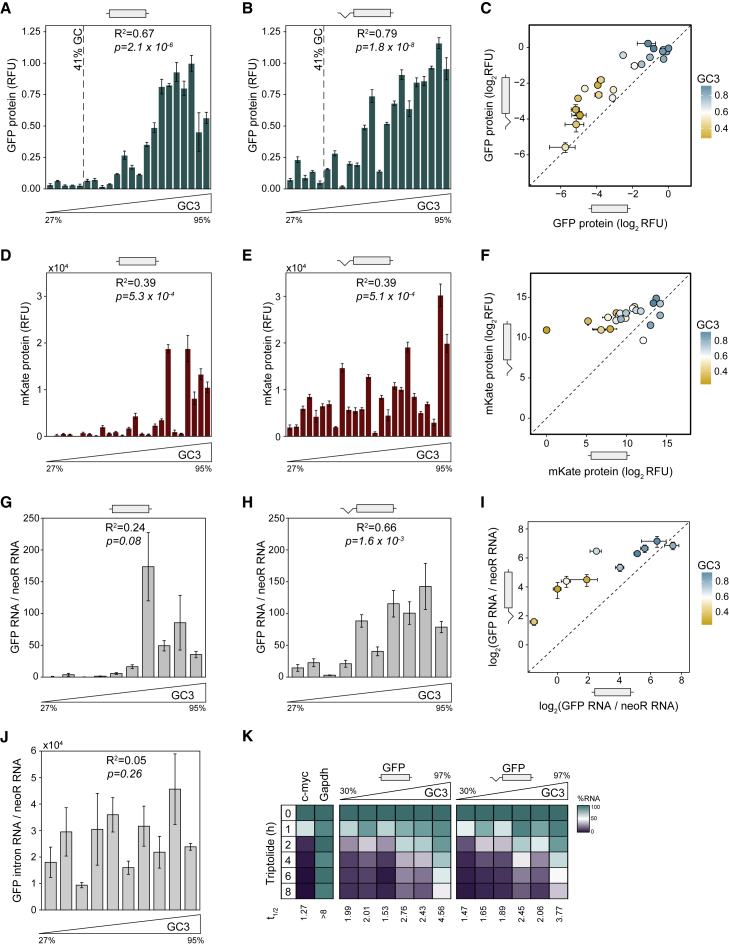
The Effect of GC Content on Gene Expression Depends on Splicing(A and B) Protein levels of 22 GFP variants when transiently expressed as unspliced (A) or spliced (B) constructs in HeLa cells and quantified by spectrofluorometry. Each data point represents the mean of 9 replicates ± SEM. GFP relative fluorescence units (RFU) are defined as (GFP fluorescence − background GFP fluorescence)/(mKate fluorescence – background mKate fluorescence), where background fluorescence was measured in mock-transfected cells.(C) Correlation of protein levels between unspliced and spliced variants of GFP (n = 22, R2 = 0.69, p = 9.0 × 10−7). The dashed line indicates x = y.(D and E) Protein levels of 23 mKate2 variants in the absence (D) or presence (E) of splicing. Each data point represents the mean of 9 replicates ± SEM. mKate RFU are defined as (mKate fluorescence – background mKate fluorescence), where background fluorescence was measured in mock-transfected cells.(F) Correlation of protein levels between unspliced and spliced variants of mKate2 (n = 23, R2 = 0.29, p = 2.8 × 10−4).(G and H) mRNA levels of 10 GFP variants when transiently expressed as unspliced (G) or spliced (H) constructs in HeLa cells and quantified by qRT-PCR. Data points represent the mean of 3 replicates ± SEM, calculated as (GFP RNA)/(NeoR RNA).(I) Comparison of mRNA expression from spliced and unspliced GFP variants (n = 10, R2 = 0.49, p = 0.014).(J) Intronic RNA levels of GFP variants measured by qRT-PCR, calculated as (GFP intronic RNA)/(NeoR RNA).(K) RNA stability time course of 6 GFP variants expressed from stably transfected HEK293 Flp-In T-REx cells after blocking transcription with 500 nM triptolide. Variants were expressed as unspliced and spliced constructs. Results represent the averages of 2 independent experiments. RNA stability of c-myc (n = 12) and GAPDH (n = 6) are shown as unstable and stable RNA controls.See also Figures S2 and S3.